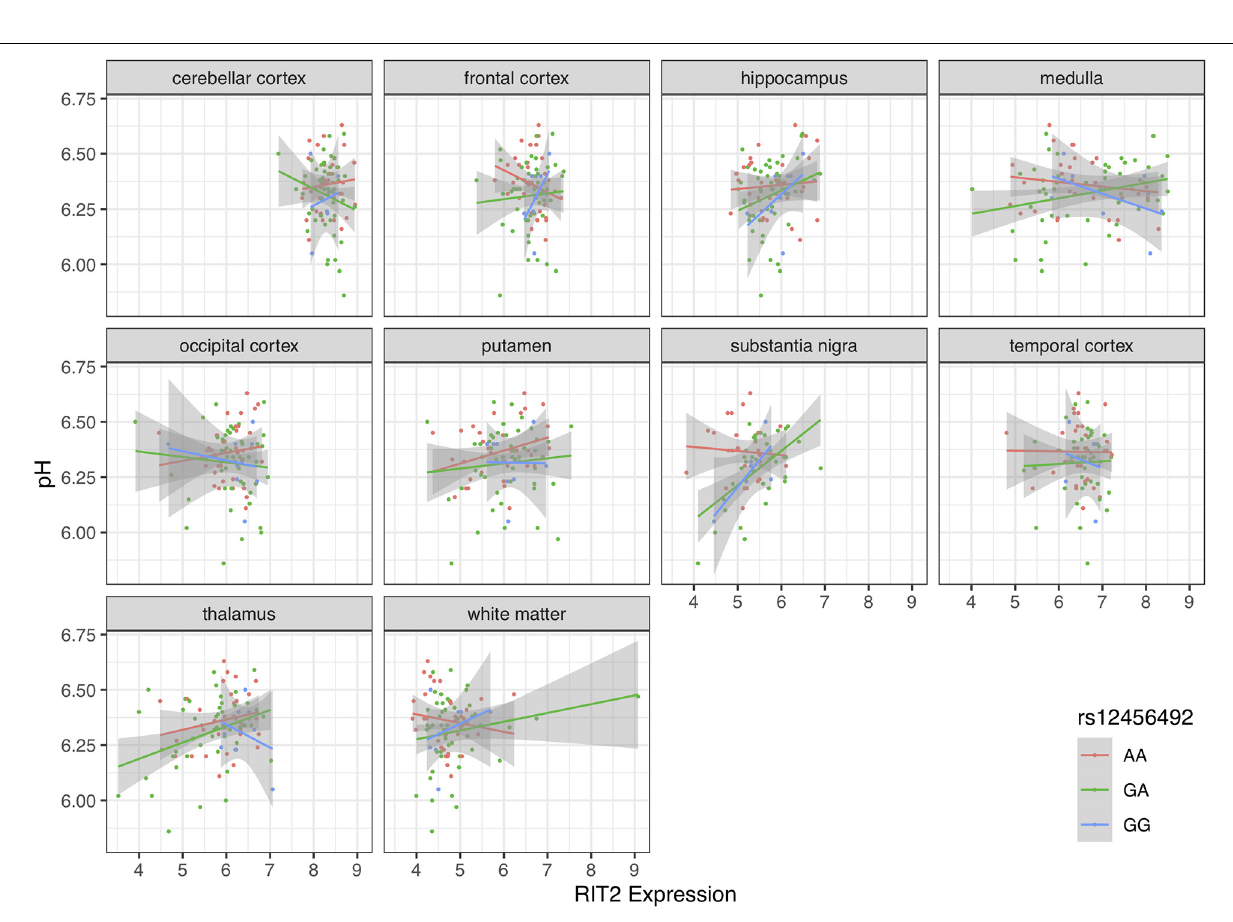
Frontiers in Aging Neuroscience |